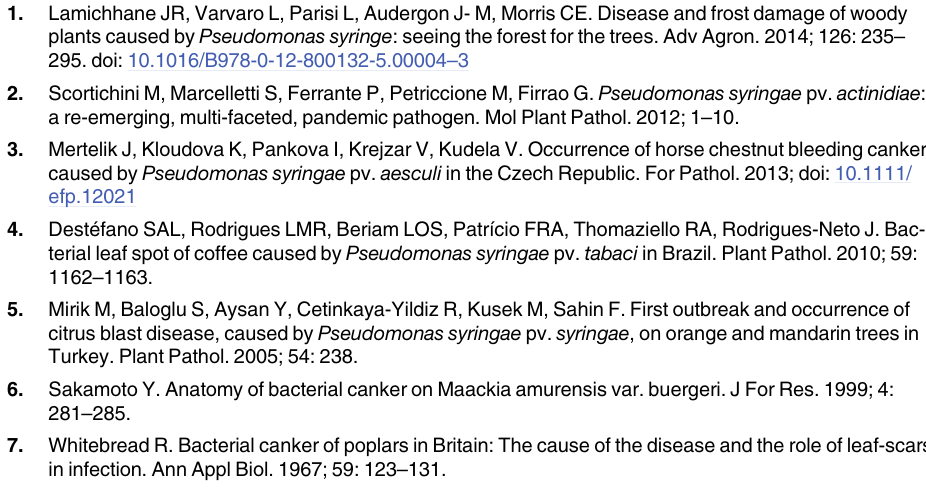
S1 Fig. Bayesian tree constructed on the concatenated sequences of gyrB, rpoD and gapA (1049bp; see the Fig 4 legend for detailed information). S1 Table. Study areas, hazelnut cultivars, plant age and hazelnut decline incidence across